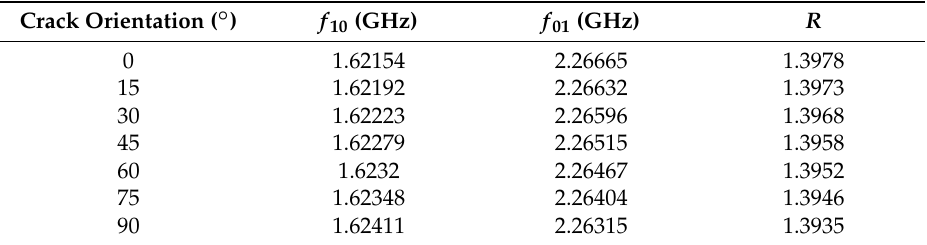
Table 4. Detection results of crack direction.